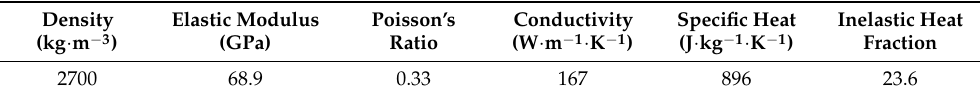
Table 2. Johnson-Cook model parameters of Al6061-T6 [30]. Table 3. Mechanical and thermal properties of Al6061-T6 and tool materials